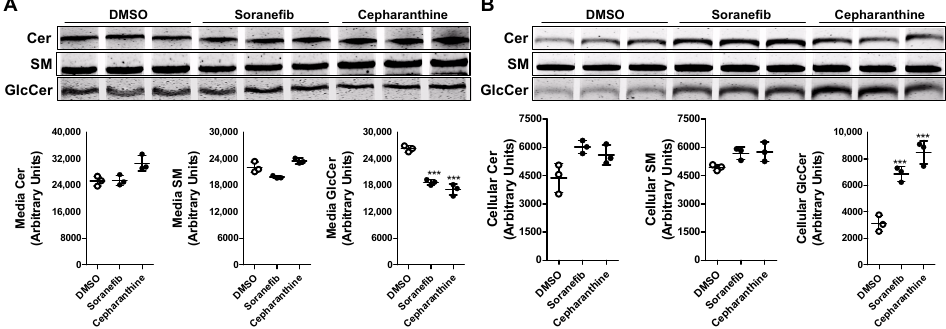
Figure 5. Post-treatment of ABCC10 inhibitors affects only the efflux and not synthesis of GlcCer in Huh-7 cells. Huh-7 cells were labeled with 2 µ M of C6-NBD ceramides in 10% FBS containing DMEM for 3 h to synthesize HexCer. Cells were washed three times with 0.1% BSA containing DMEM, and then incubated with 40 µ g/mL of HDL in the presence of 5 µ M sorafenib or cepharanthine for 6 h to study GlcCer efflux. Media and cells were collected to extract lipids. Lipids were separated in the media ( A ) and cells ( B ) on TLC plate and fluorescence in Cer, SM, and GlcCer bands was visualized with the PhosphorImager (top) and quantified using ImageJ software (bottom). Values are plotted as replicates (mean ± SD), *** p < 0.001 compared with DMSO-treated